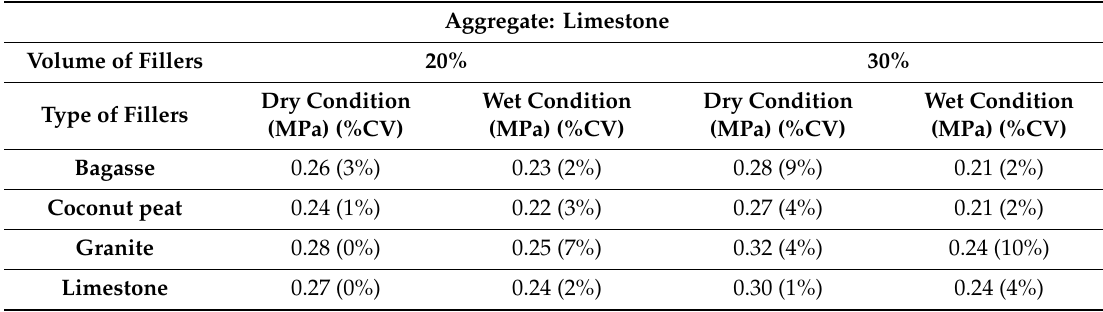
Table 2. Indirect tensile strength (ITS) of dry and wet conditions on asphalt mixtures with limestone and di ff erent filler contents (i.e., 20% and 30% by volume).